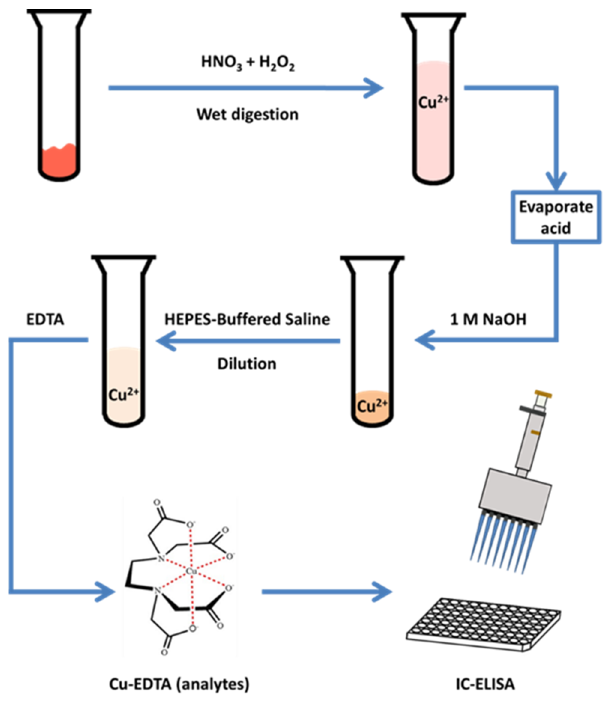
Figure 1. Immunoassay procedure for copper residues in animal tissues.